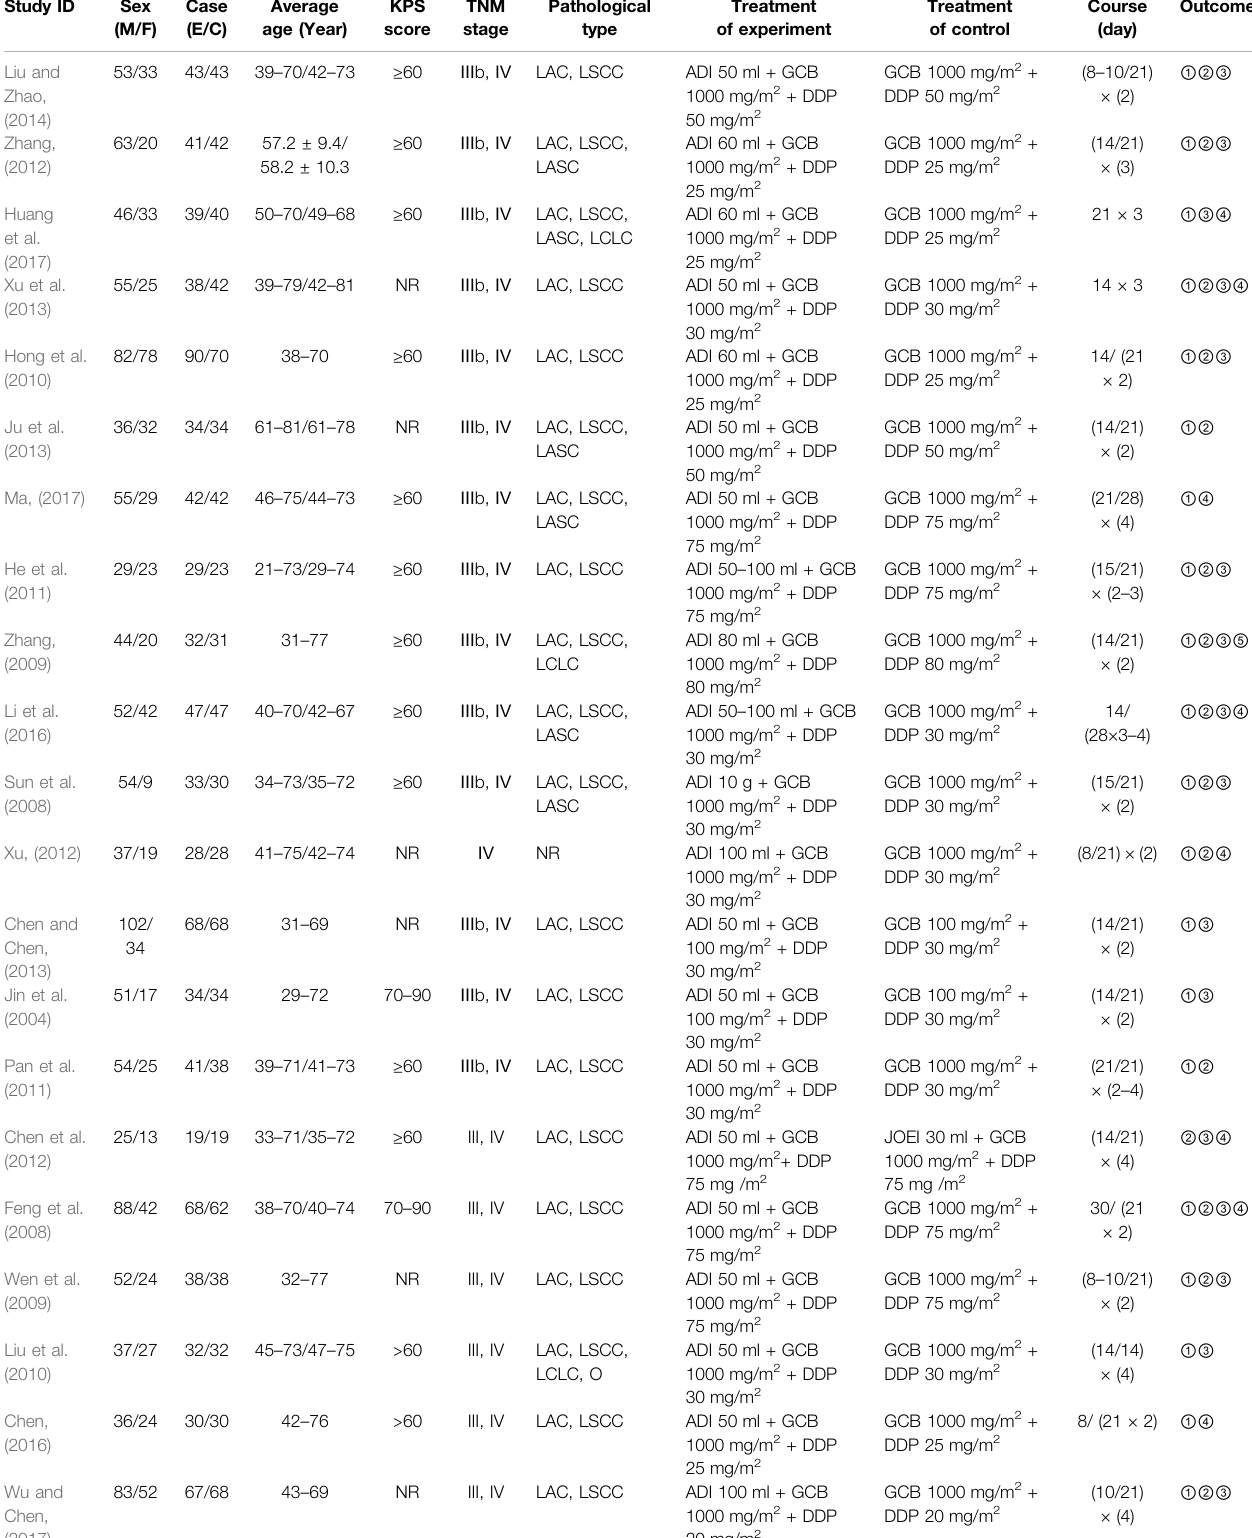
TABLE 1 | Characteristics of the included randomized controlled